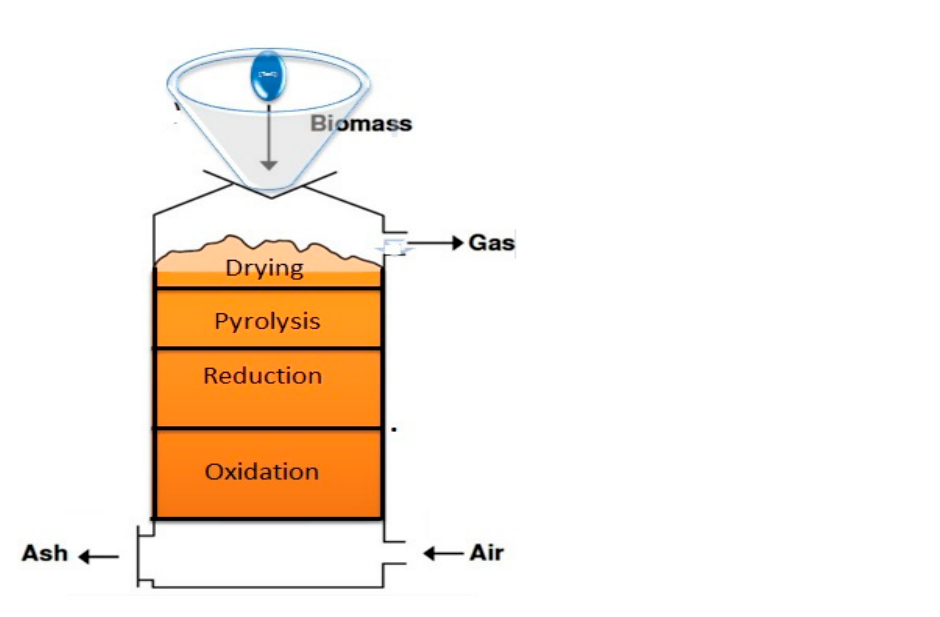
Figure 4. The updraft fixed bed gasifier process, including the spatial location of the oxidation, reduction, pyrolysis, and drying processes occurring in the reactor.